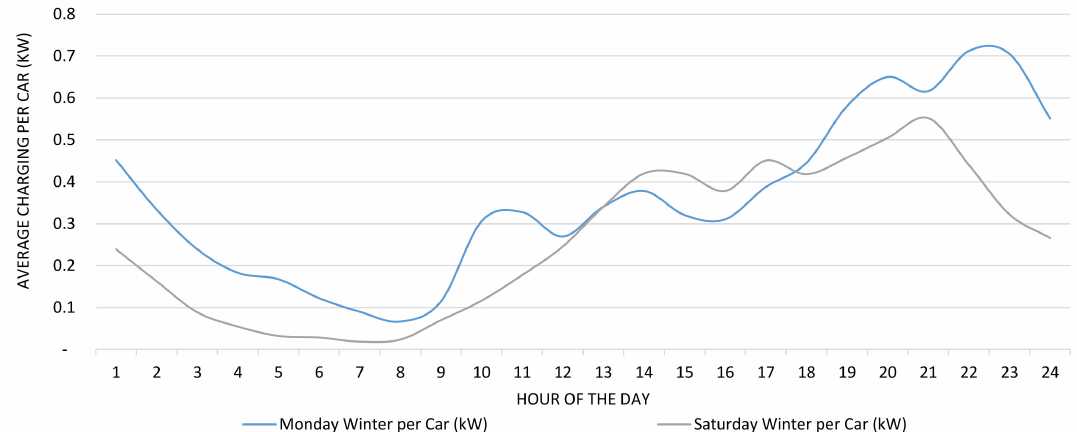
Figure 4. Load per BEV for a Monday (blue line) and a Saturday (grey line) in winter